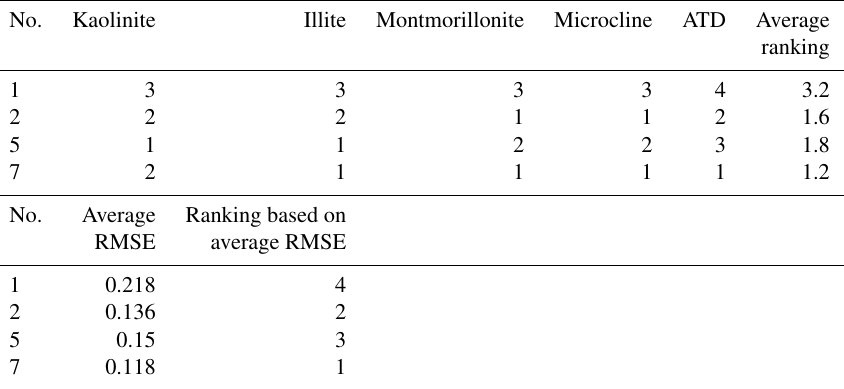
Table 3. Ranking of the capability of the different CNT formulations to reproduce the freezing curves for different mineral dust particles based on the RMSE between the calculated freezing curve and the measured freezing